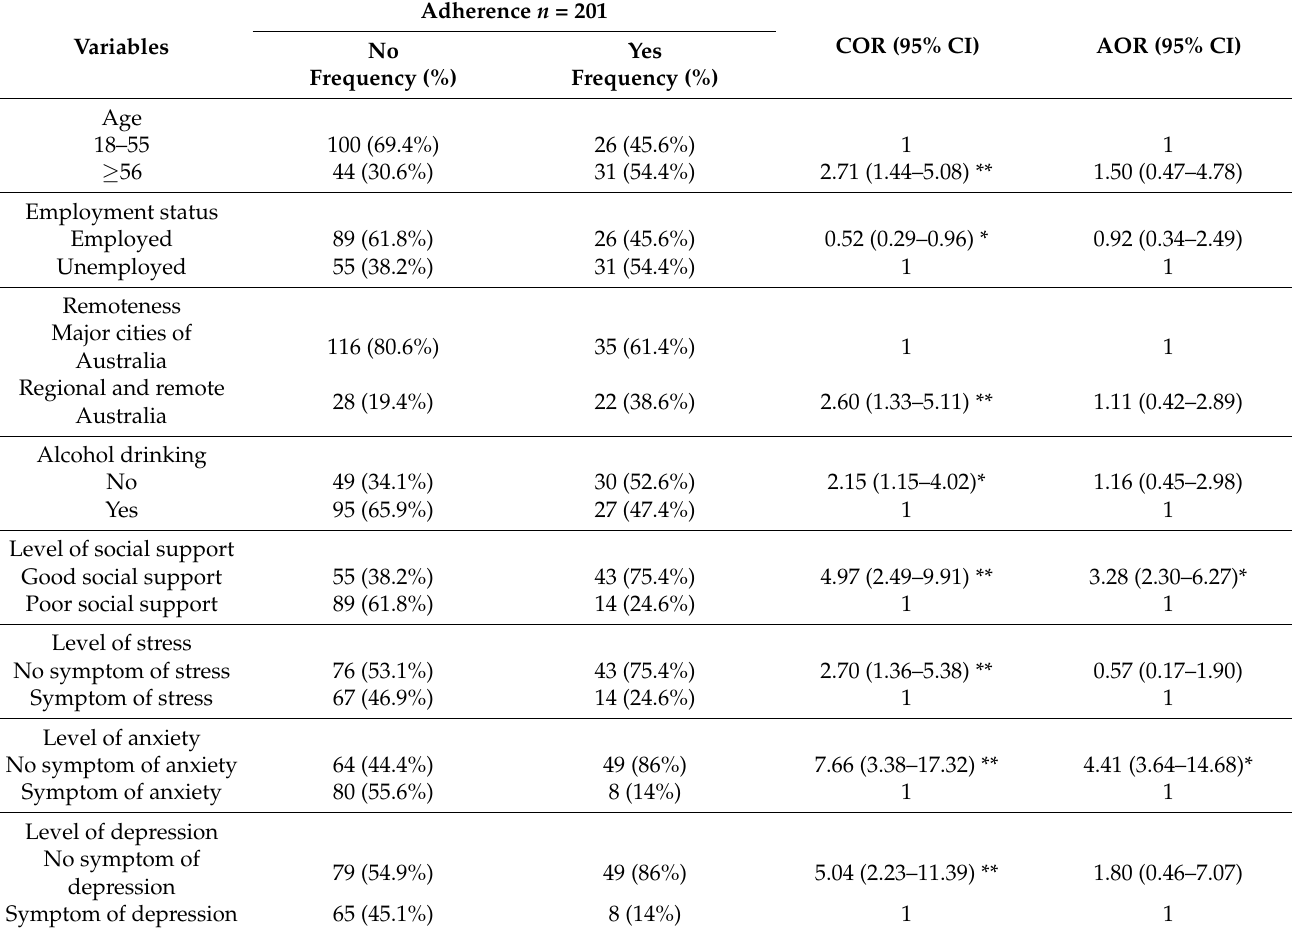
Table 3. Factors associated with self-reported adherence to SCMs among smokers and ex-smokers in Australia aged 18 and above ( n =